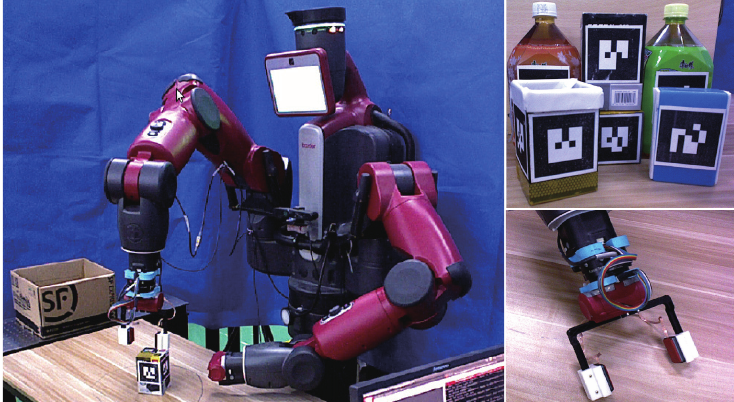
Figure 2. Autonomous kitting experiment by Baxter robot: The robot is designed to transport 6 markered objects with variable weights and shapes (shown in the top-right subfigure) to a container, where the external anomalies may arise from accidental collisions (human–robot, robot–world, robot/object–world), mis-grasps, object slips, etc. To detect and classify those anomalies, the robot arm is integrated with multimodal sensors (shown in the bottom-right), including internal joint encoders, F/T sensor, tactile sensor,